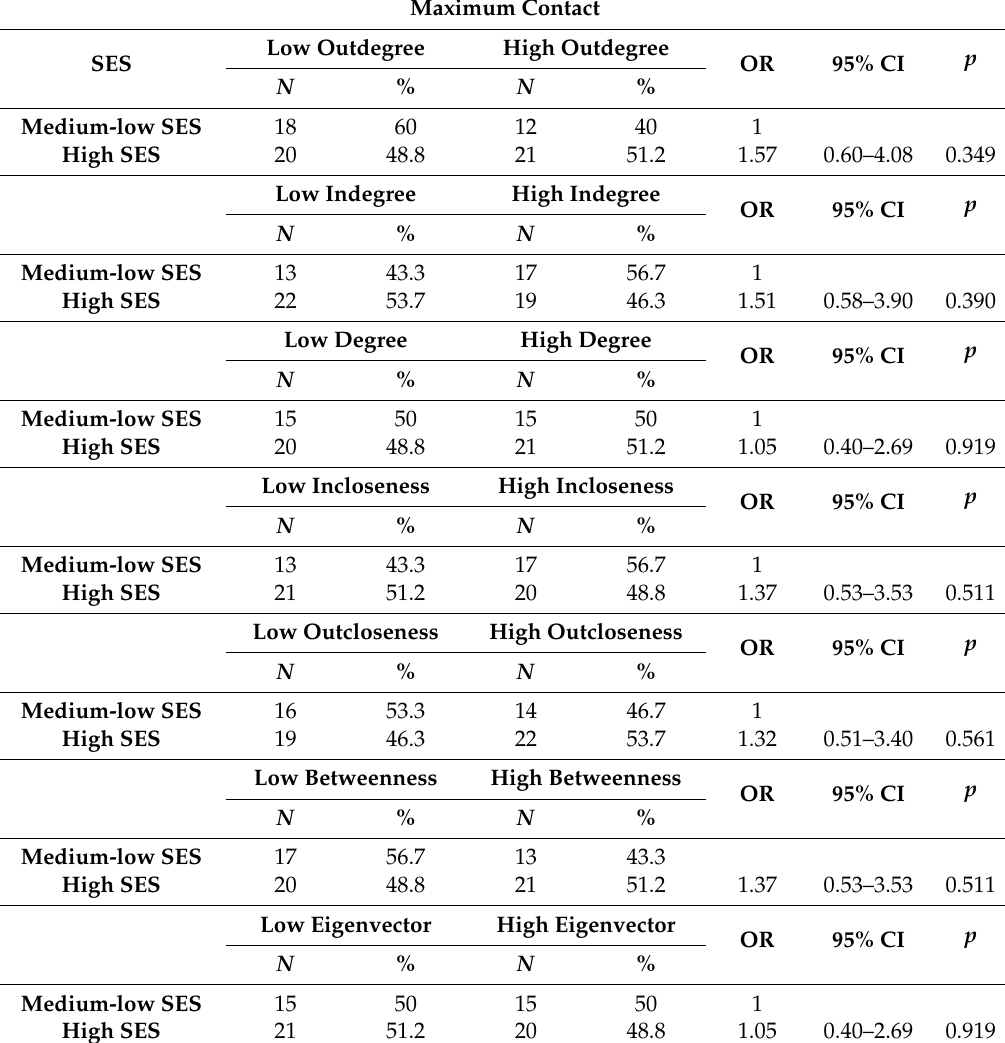
Table 6. Estimation of probability in an analysis of the relationship between SES in the overweight adolescent and network parameters, at the maximum contact intensity level Maximum Contact Low Outdegree High Outdegree SES OR 95%